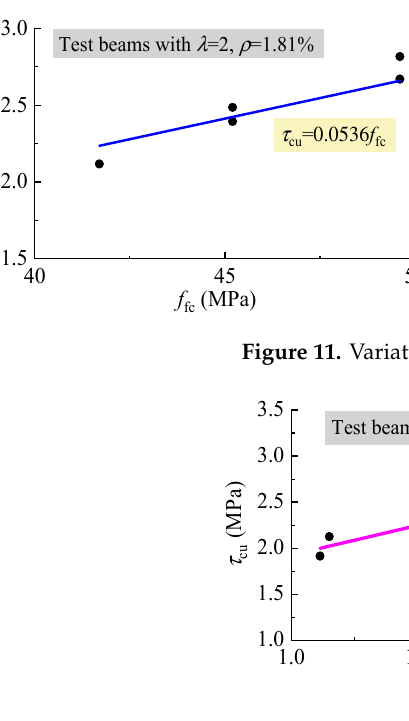
Figure 10. Variations of f fc and α ft / c with λ f .